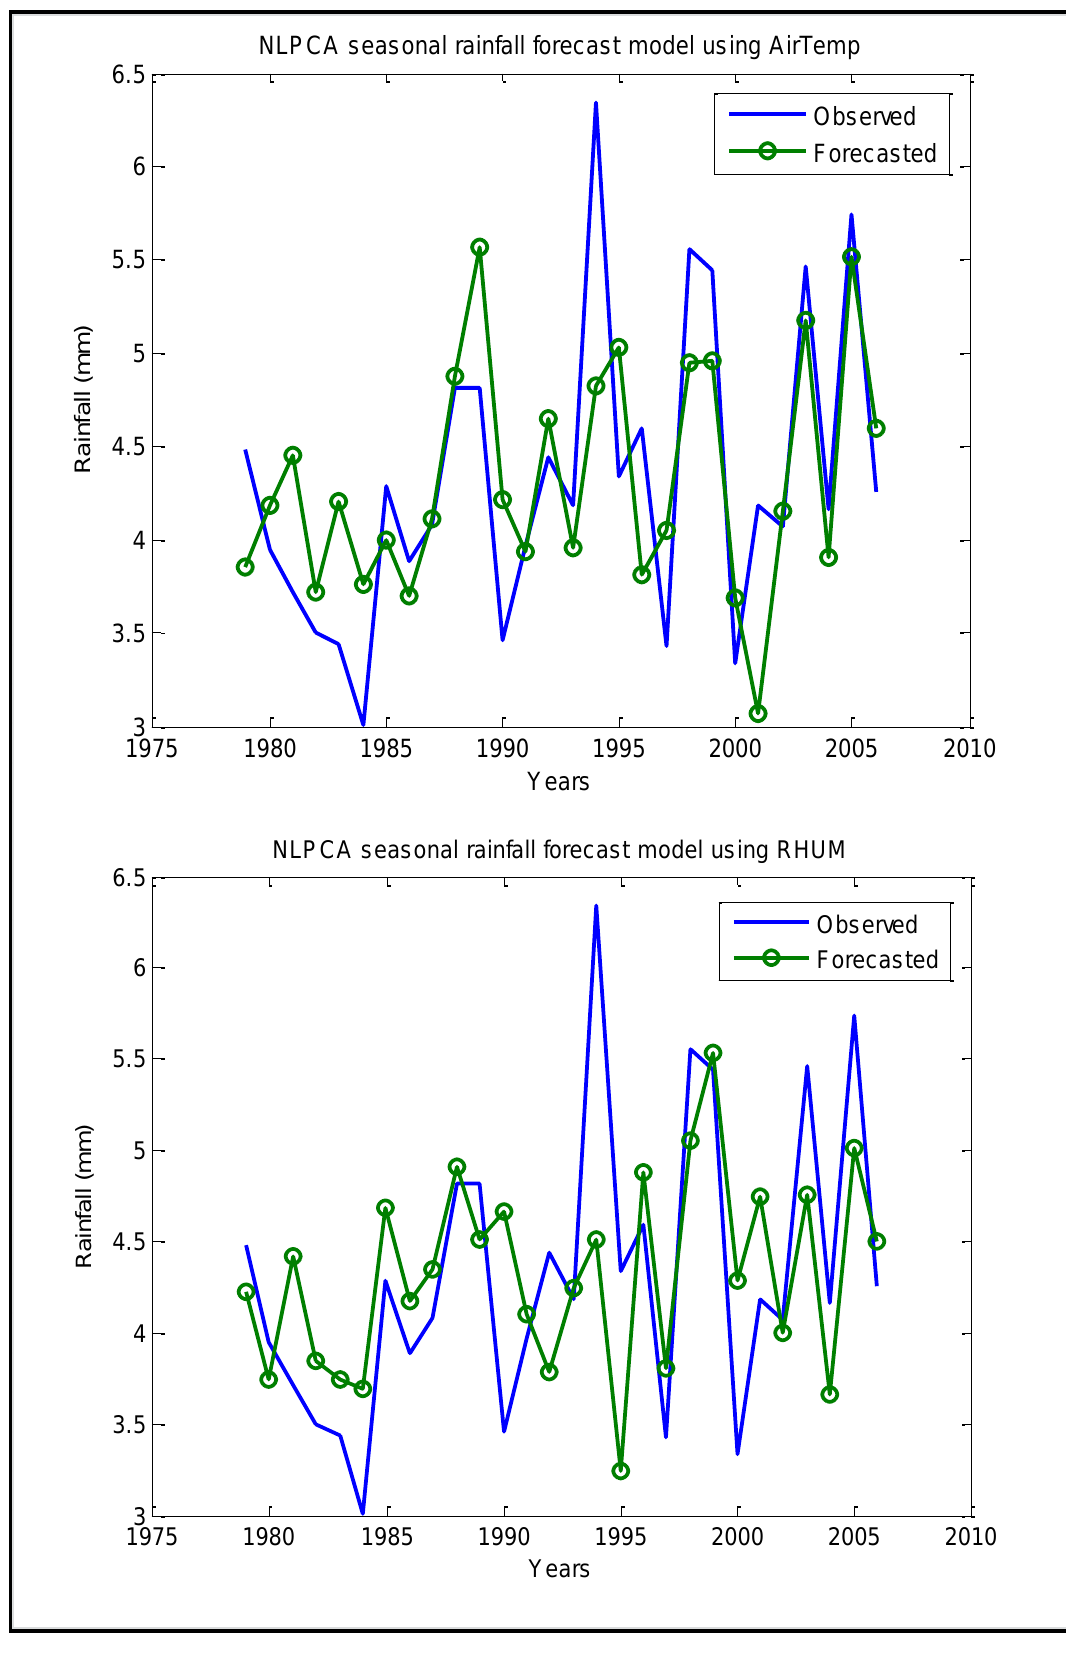
Figure 8. NLPCA seasonal rainfall forecast model using AirTemp (upper panel) and RHUM (lower